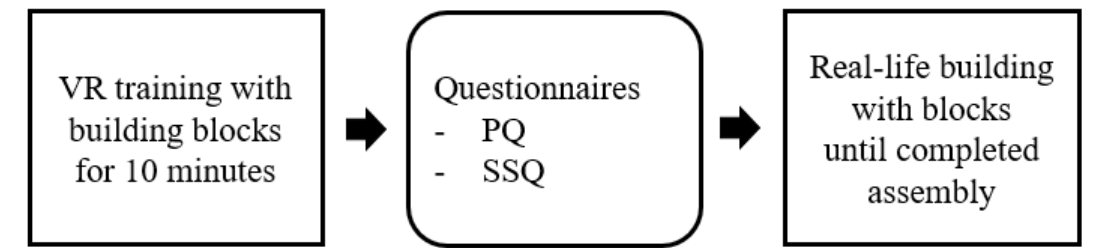
Figure 2. Study design of the current experiment.